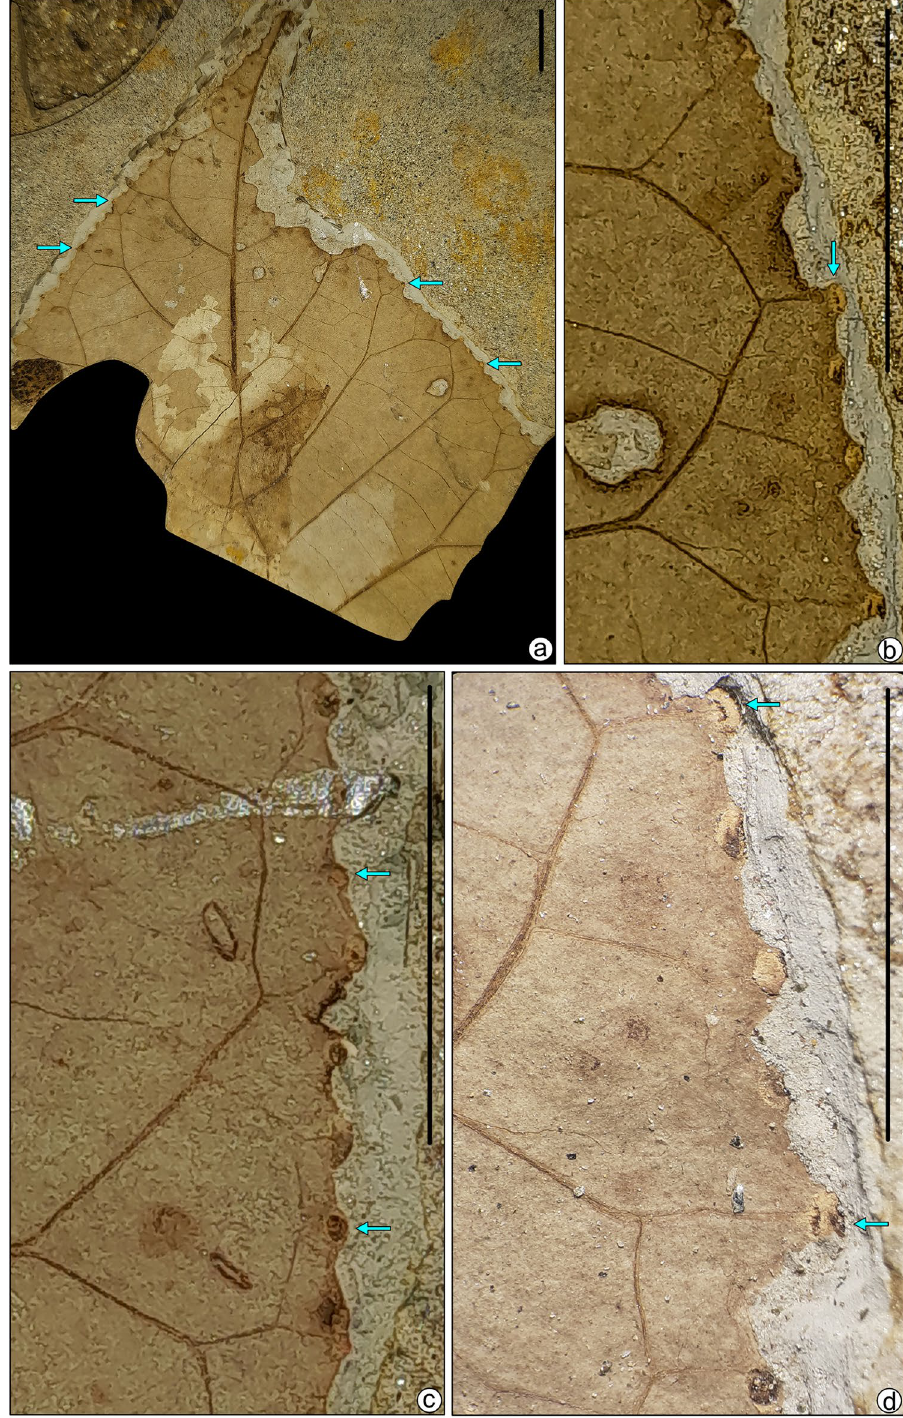
Figure 2. ( a ) Margin gall bearing of fossil leaf samples SKBUH/PPL/JH/325C. ( b–d ) Enlarged view of ( a ); scale bar = 1